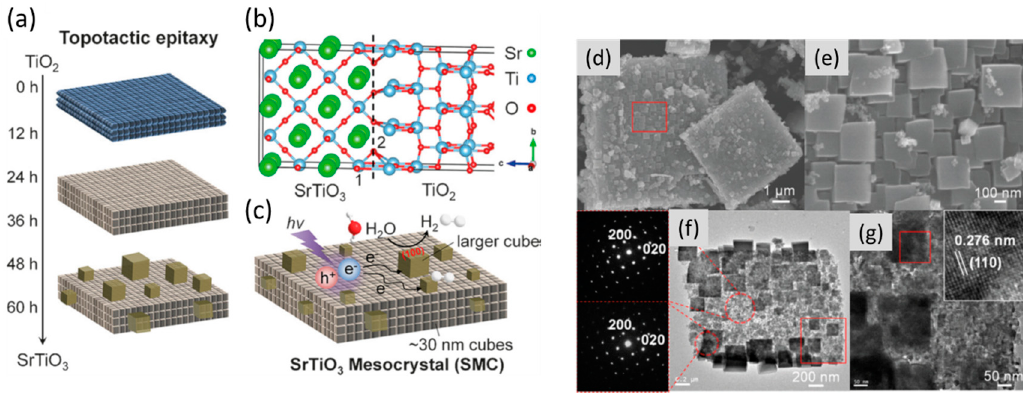
Figure 9. ( a ) Schematic illustration of the formation of SrTiO 3 mesocrystals (consisting of aligned nanocubes with dominant {100} facets) via topotactic epitaxial transformation of TiO 2 . ( b ) Structural model of interface between SrTiO 3 and TiO 2 illustrating the epitaxial intergrowth of both phases. ( c ) Simplified scheme of a SrTiO 3 mesocrystal showing the photogeneration of electrons and holes and anisotropic electron transport from the inside to the outside. ( d ) Field emission SEM image of typical SrTiO 3 mesocrystals, ( e ) zoomed image inside the red frame marked in ( d ). ( f ) TEM image and corresponding ED patterns of SrTiO 3 mesocrystals. ( g ) High resolution TEM image of the area marked with the red-square in ( f ). Figures are adapted from Ref. [86] with permission of the Wiley-VCH Verlag GmbH & Co. KGaA, Weinheim.